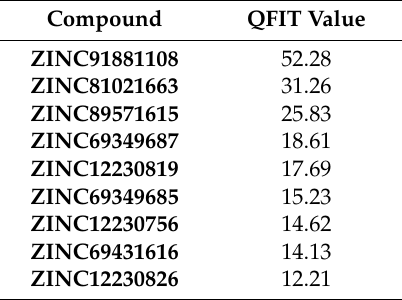
Table 7. Compounds with QFIT > 0, which were analyzed using the CHEMGPS-NP server.